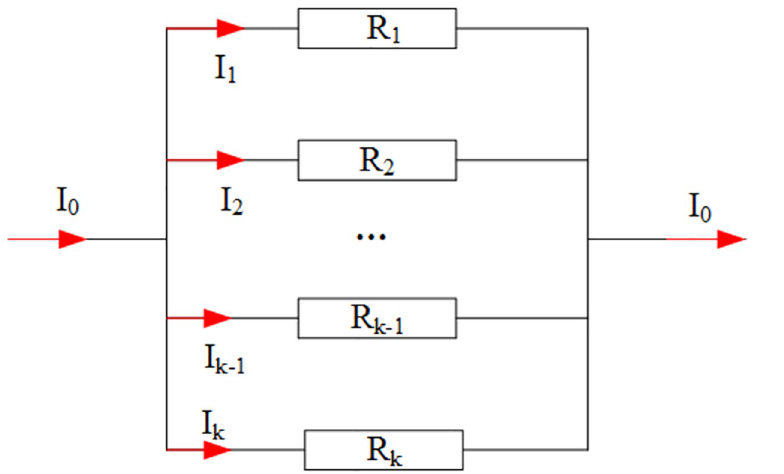
Fig 6. Schematic diagram of a parallel